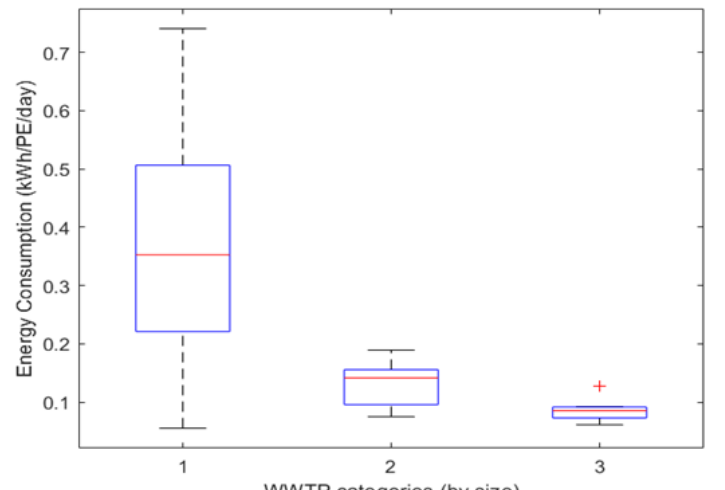
Figure 2. Energy Consumption by size of WWTP.